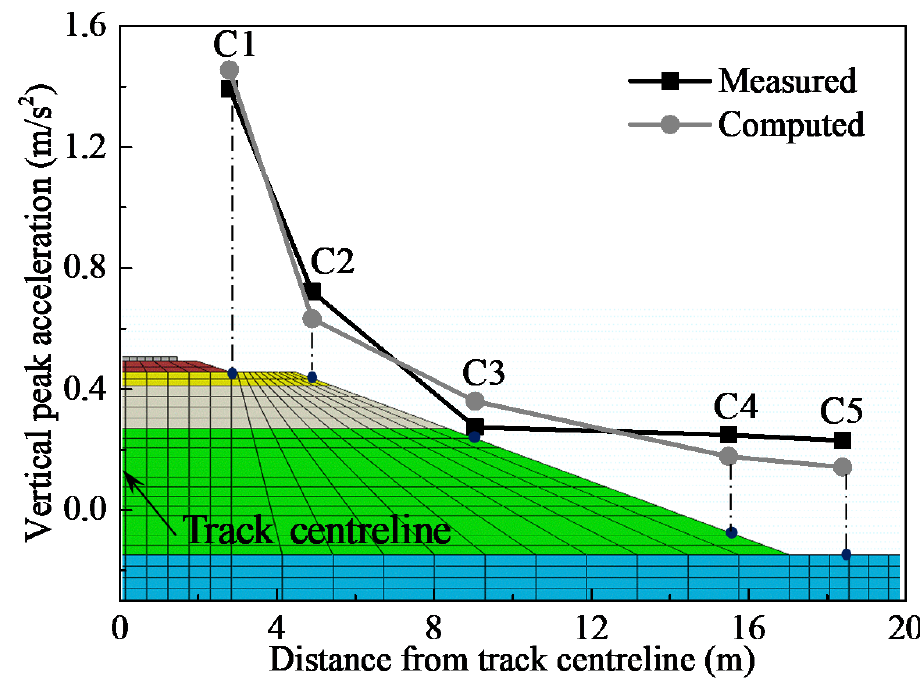
Figure 8. Comparison of peak accelerations values of the subgrade with the distance from the track centerline.